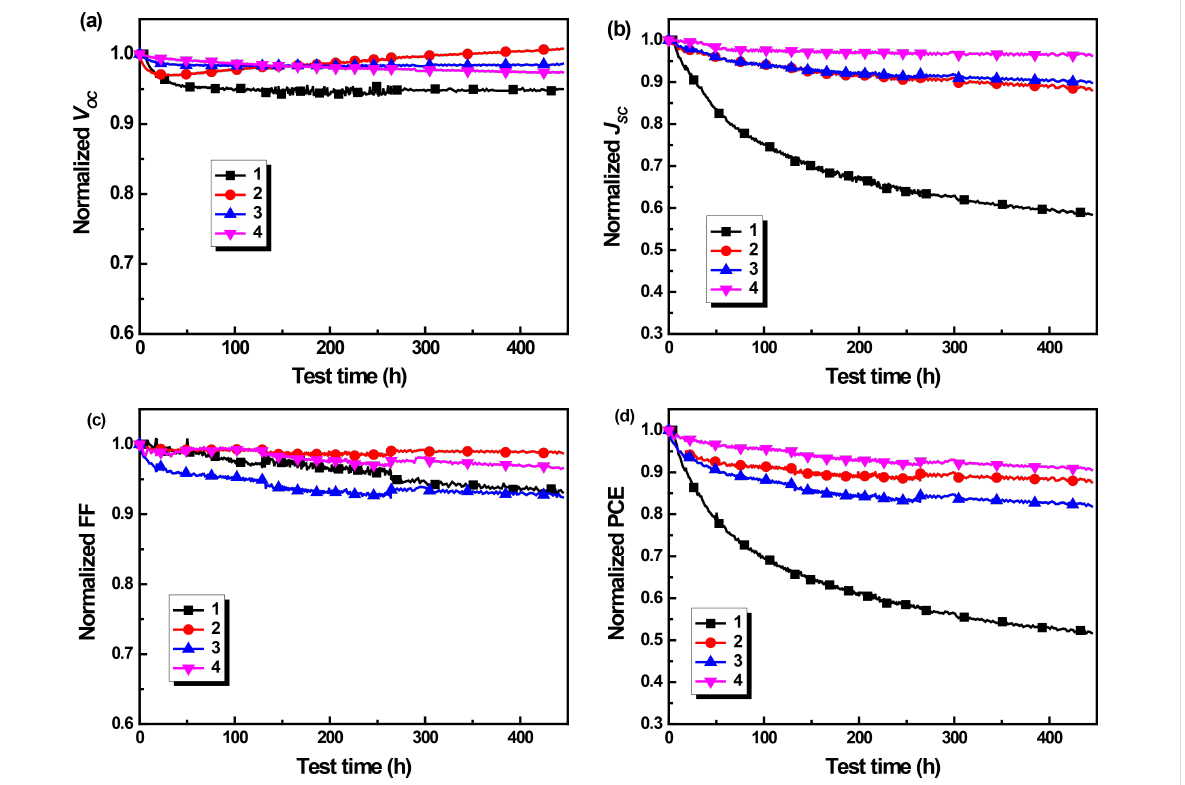
Figure 6: (a) V OC , (b) J SC , (c) FF, and (d) PCE decay of the COOP- n HT-TBDT:PC 61 BM solar cells. Note all these data are normalized to their initial